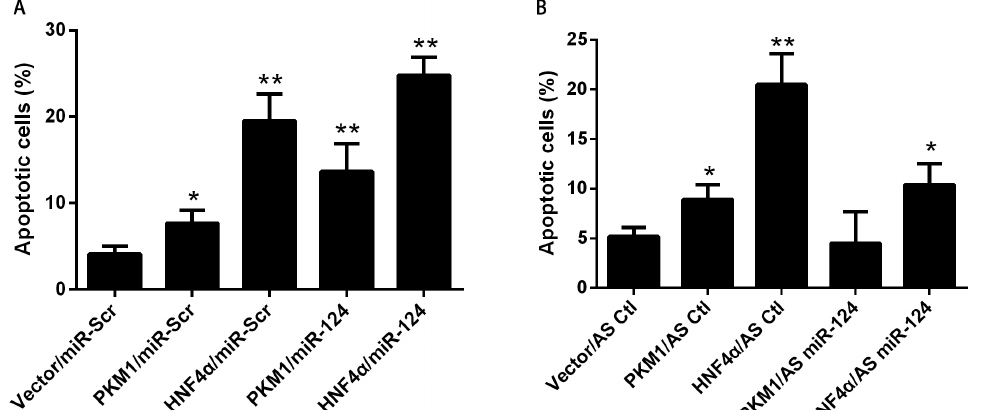
Figure 4. PKM1/HNF4 α regulates apoptosis via miR-124. To determine the role of miR-124 in PKM1/HNF4 α -induced apoptosis, ( A ) HCT116 cells were cotransfected with HA-PKM1, Flag-HNF4 α or empty plasmid (vector) together with miR-124 or miR-Scr for 48 h; ( B ) HCT116 cells were cotransfected with HA-PKM1, Flag-HNF4 α or empty plasmid (vector) together with AS-miR-124 or AS-Ctl for 48 h; ( A , B ) Apoptosis was analyzed by Annexin V/PI assay; ( C , D ) The anchorage-independent cell growth was analyzed by colony formation assay; ( E ) Working model, in summary, MiR-124 regulates the ratio of PKM1/PKM2 via targeting PKM splicing proteins (PTB/hnRNAP1/hnRNAP2). The ratio of PKM1/PKM2 determines the apoptosis rate of cancer cells. In the meantime, PKM1 exerts positive feedback regulation on miR-124 level through HNF4 α transcription factor. The data are presented as mean ± SD of three independent experiments. * p < 0.05 vs. control, ** p < 0.01 vs.